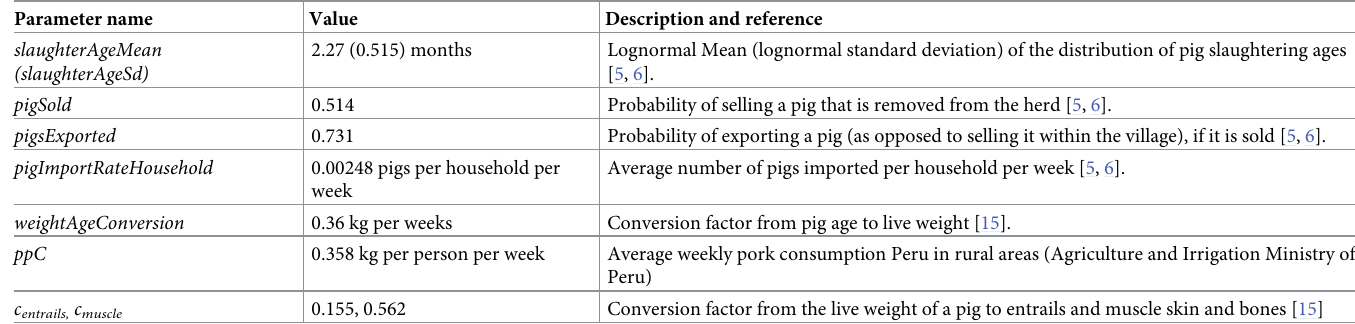
Table 2. Household module